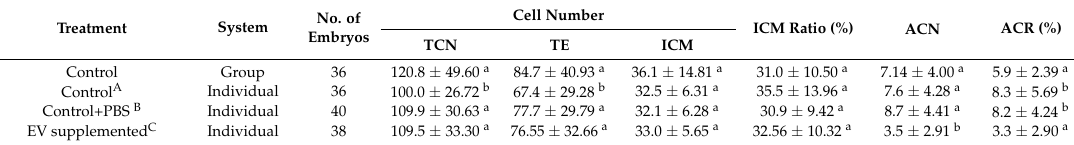
Table 4. Quality assessment of individual cultured bovine embryos after EV supplementation.